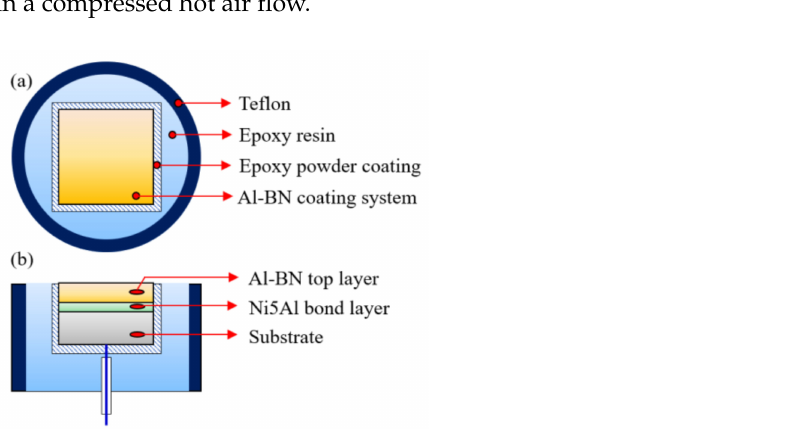
Figure 2. Schematic diagram of the Al–BN ACS electrode; top view ( a ) and cross-section ( b